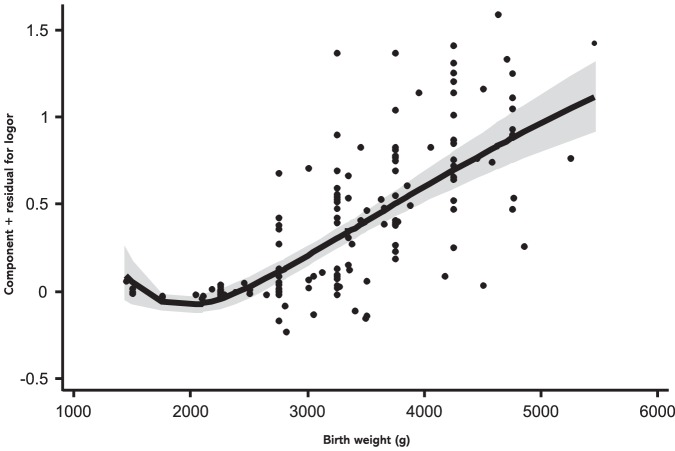
Relationship between birth weight and risk of overweight.Continuous relation between birth weight and later risk of overweight, calculated by fractional polynomial regression. Studies are represented by black dots. Grey shading indicates the 95% confidence interval around the fitted line. The model was estimated from a robust regression model based on second-order fractional polynomial (−1, −0.5) functions weighted by/variance.